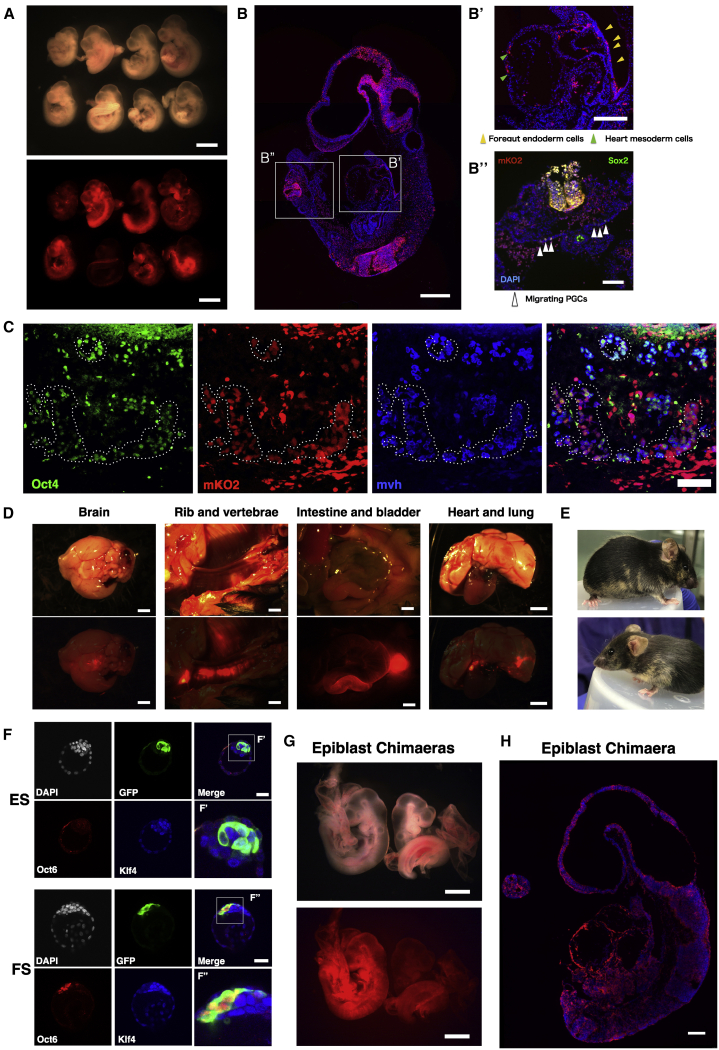
Blastocyst Chimera Contribution by FS Cells and Formative Epiblast(A) Bright-field and fluorescent images of E9.5 embryos generated after blastocyst injection of mKO2 reporter FS cells. Scale bar, 1 mm.(B) Sagittal section from one chimera, stained for mKO2 and DAPI. (B’), mKO2-positive cells in foregut endoderm (yellow arrowheads) and cardiac mesoderm (green arrowheads). (B’’) (rotated 90°), Sox2 immunostaining (white arrowheads) in the hindgut region. Scale bars, 200 μm (B) and 100 μm (B’and B”).(C) mKO2-positive cells expressing Oct4 and Mvh PGC markers in E12.5 chimeric gonad. Triple-positive cells are highlighted with dashed circles. Scale bars, 75 μm.(D) Fluorescent images of organs from post-natal day 21 (P21) chimera overlaid with 20% opacity bright-field image. Scale bars, 2 mm.(E) Coat color chimeras generated from NBRA3.2 FS cells at 7 weeks (above) and 4 weeks (below).(F) Blastocysts injected with GFP reporter ESCs or FS cells and cultured for 24 h. ESCs are Klf4+Oct6− (n = 11) (F’), whereas FS cells are Klf4−Oct6+ (F’’) (n = 15). Scale bars, 40 μm.(G) E9.5 chimeras obtained from blastocyst injection of mTmG expressing E5.5 epiblast cells. Scale bars, 500 μm.(H) Section from left embryo in (G) stained with anti-RFP to visualize membrane-tdTomato; DAPI in blue. Scale bar, 200 μm.